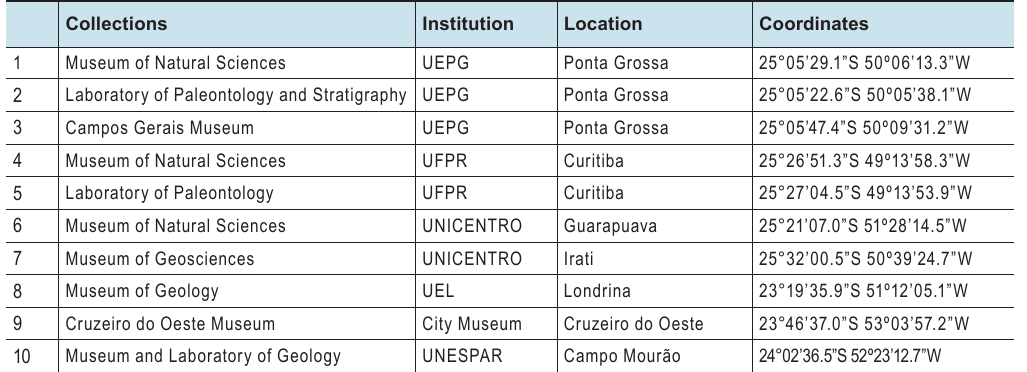
Table 2: Main paleontological collections in Paraná State.